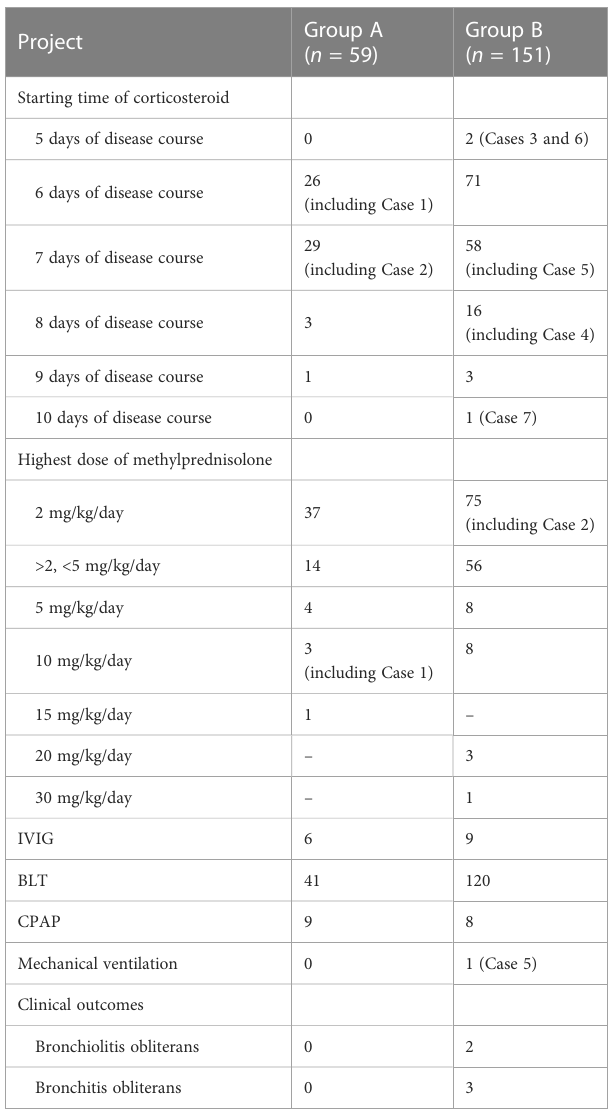
TABLE 2 Treatment and clinical outcomes in MPP patients.